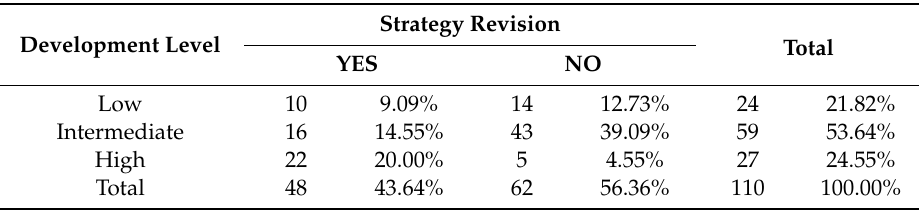
Table 4. Contingency table of absolute and relative (as % of the total) frequencies of PMM system development level and strategy and process revision.